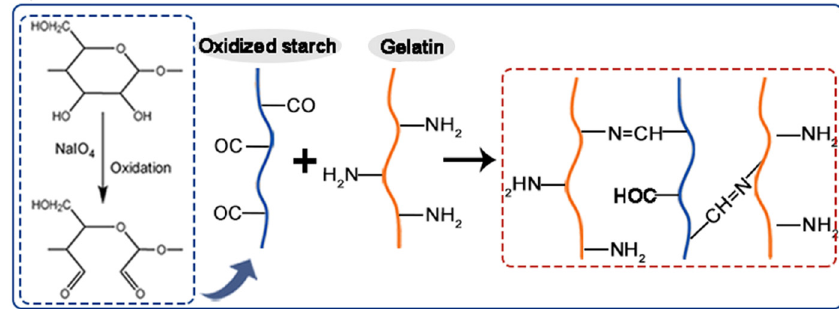
Figure 8: Schematic representation of OSG hydrogel synthesis. Copyright 2020, Elsevier ( 108 )